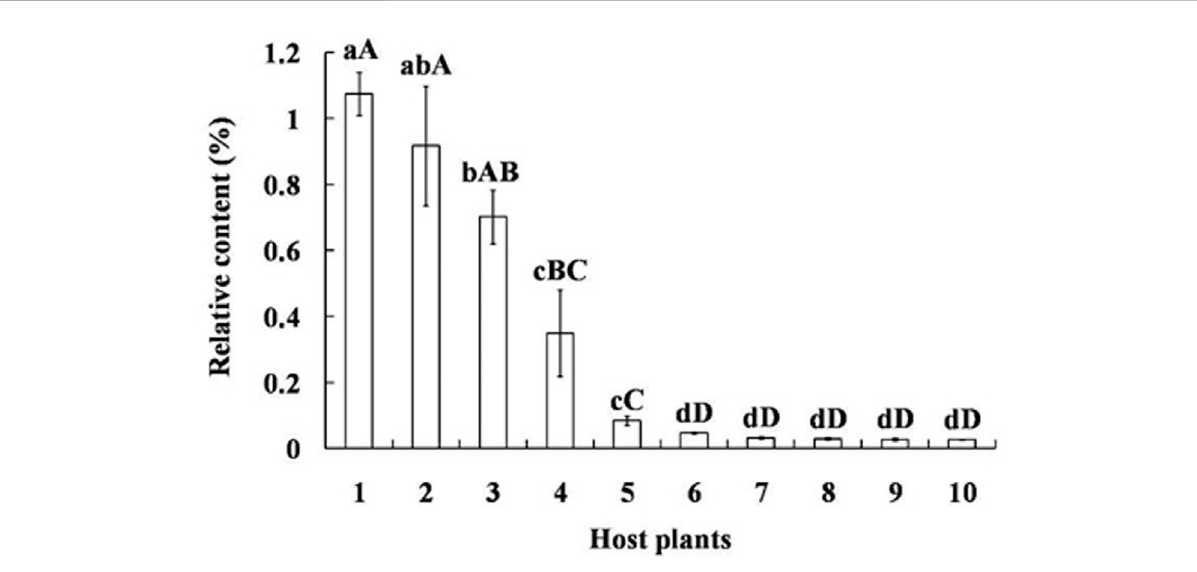
FIGURE 4 Relative content of tetradecane among volatiles of different plants exploited as hosts by mirid bugs. Different uppercase and lowercase letters indicated highly signi fi cant ( p < 0.01) and signi fi cant ( p < 0.05) differences in the relative contents of tetradecane among ten host plants ( Least signi fi cant difference test ). Numbers on the horizontal axis represent: 1. Fruits of Vitis vinifera , 2. Seedling of Pisum sativum , 3. Fruits of Zea mays , 4. Fruits of Pyrus bretschneideri , 5. Fruits of Malus pumila , 6. Buds of Gossypium herbaceum , 7. Bolls of G. herbaceum , 8. Leaves at seedling stage of G. herbaceum , 9. Leaves on the bolls of G. herbaceum , 10. Leaves on the buds of G. herbaceum .